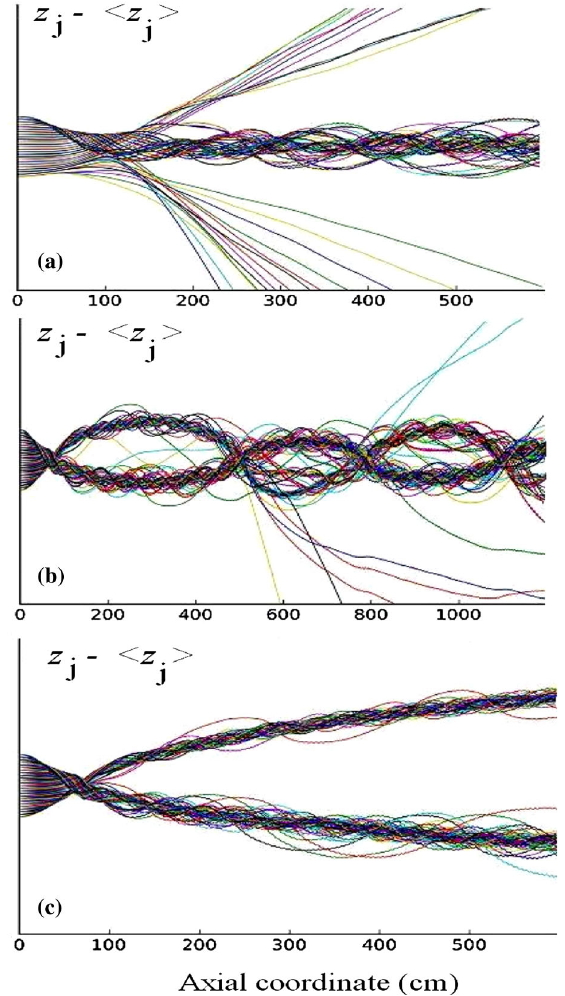
FIG. 10. Long-length dynamic of the electron bunch with an initial length of 1 mm moving through a negative-mass undulator at various mismatches between undulator and cyclotron frequen- cies, (a) Δ ¼ − 0 . 55 , (b) Δ ¼ − 0 . 48 , and (c) Δ ¼ − 0 . 46 . Axial positions of different particles with respect to the averaged center − h z i , versus the current axial of the bunch, z j j